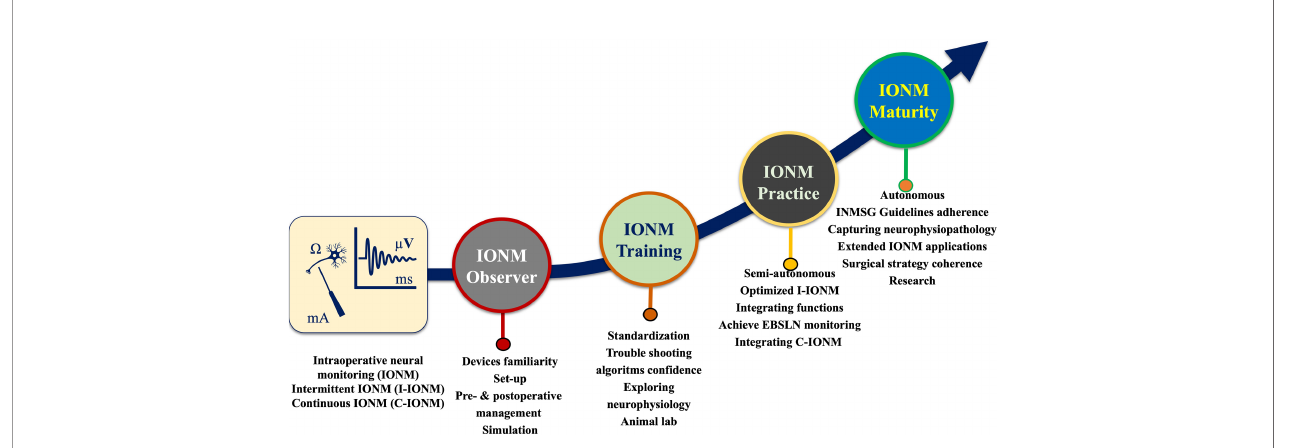
FIGURE 1 | A journey to autonomous IONM operations. Training evolution for implementation of basic and advanced IONM system (IONM needs, stages and bene fi